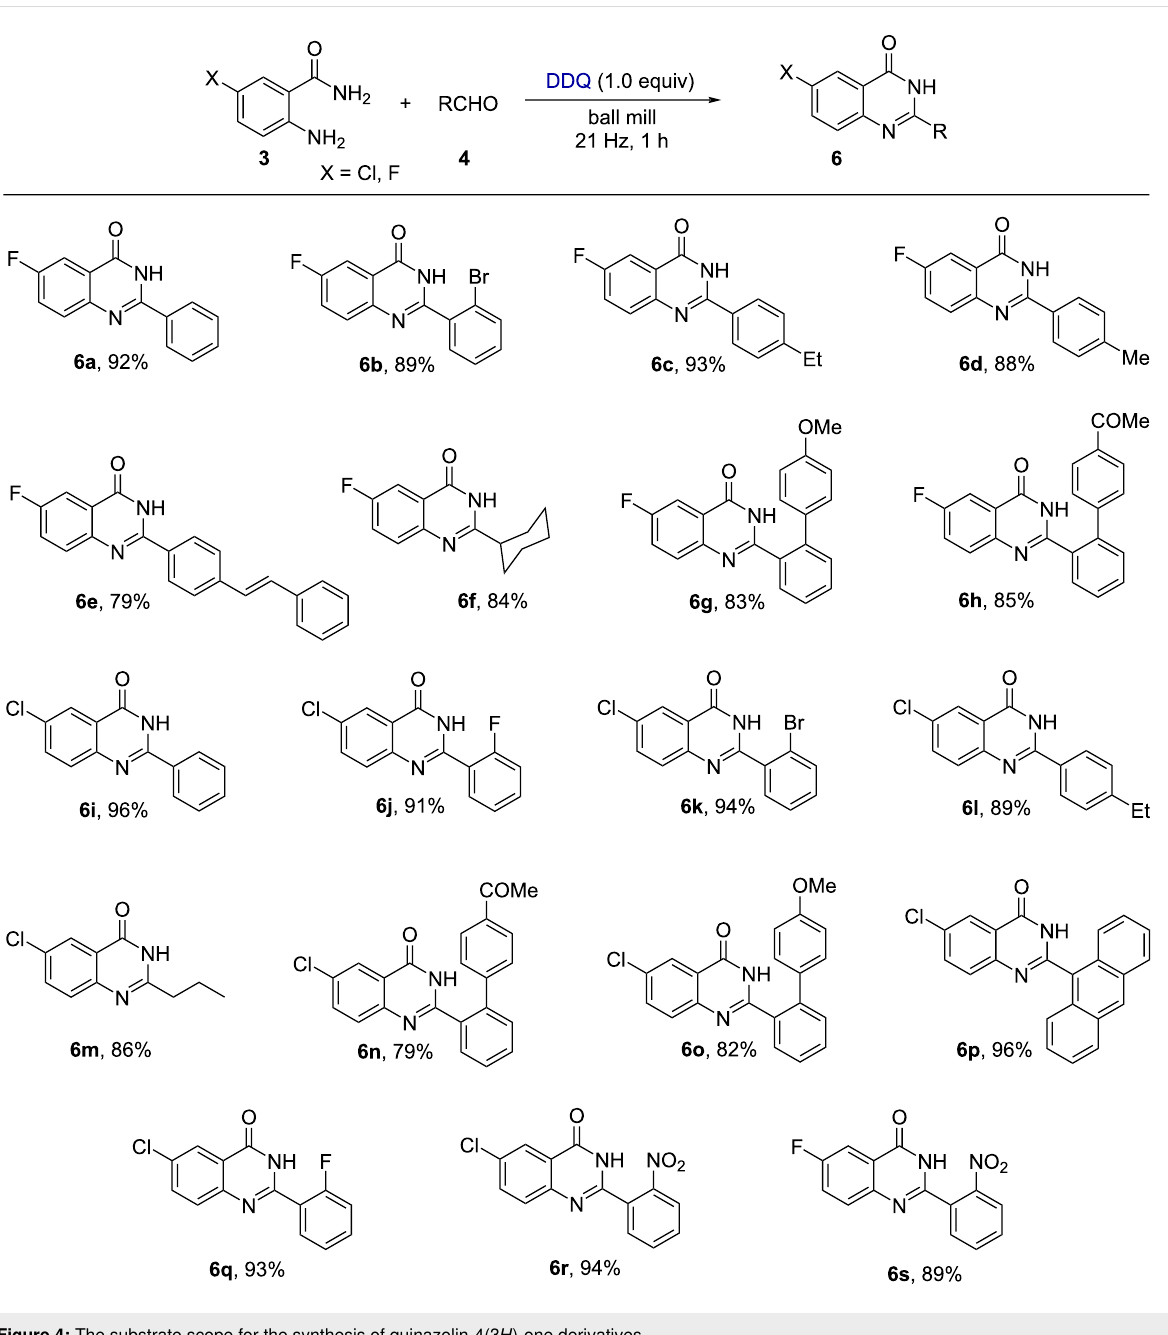
tion conditions in the presence of TEMPO or BHT, the ex- pected product 2c was formed in 66 and 72% yields. These results indicate that a radical pathway may not be involved in the reaction. So, based on literature reports [53-55], we have proposed a reaction mechanism in Figure 5b. Initially, DDQ abstracts a hydride ion from substrate 1a to generate the inter- mediate A . Then intermediate A undergoes an electrophilic intramolecular cyclization to form the cationic intermediate B